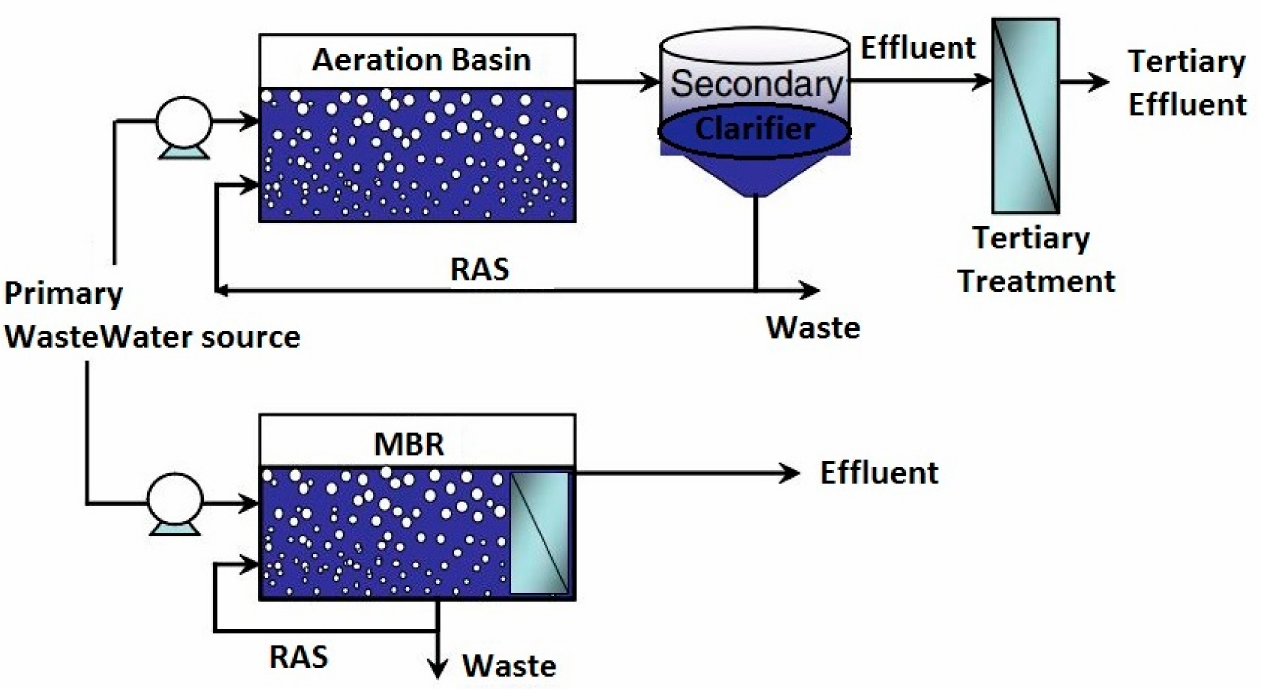
Figure 2. Difference between CAS and MBR. Adapted from